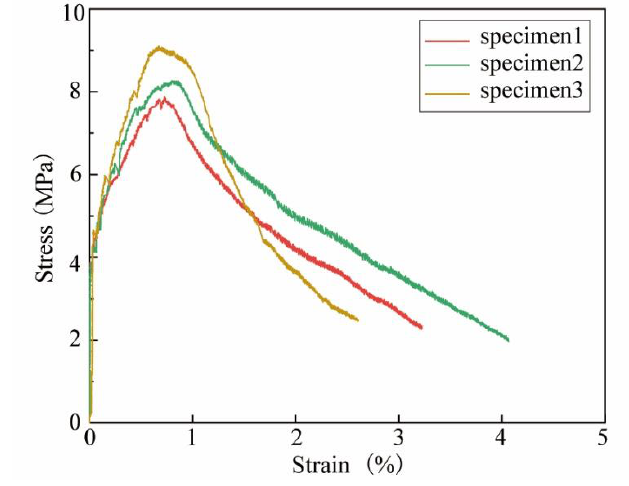
Figure 4. Tensile stress – strain curves.